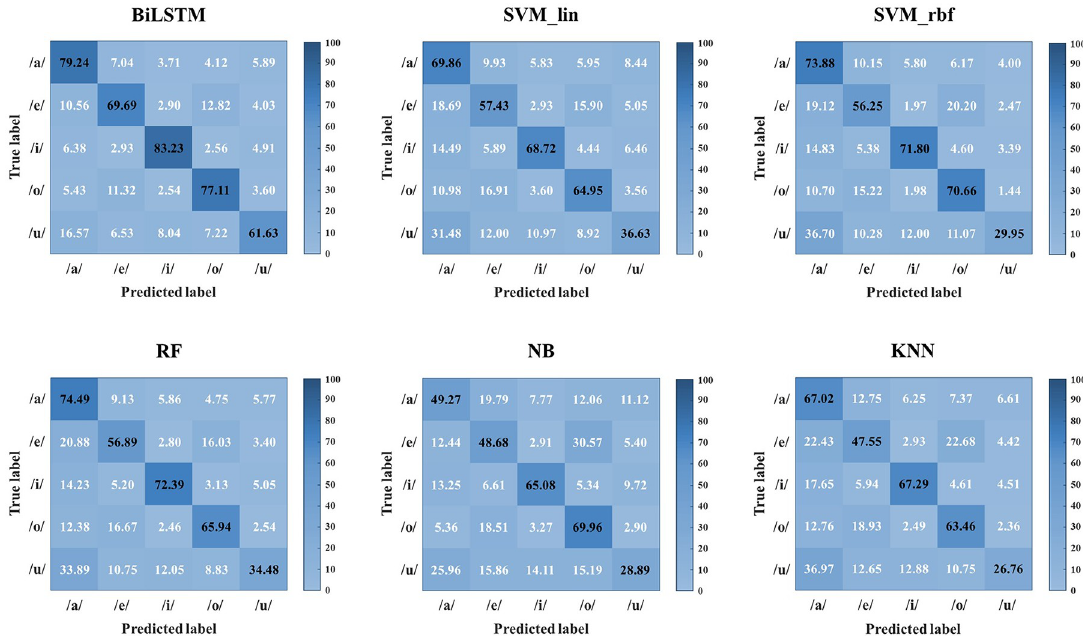
Fig 7. Confusion matrix for the BiLSTM network and other conventional machine learning classifiers. BiLSTM, bidirectional long short-term memory; SVM_lin, support vector machine with linear kernel; SVM_rbf, support vector machine with radial basis function kernel; RF, random forests; NB, na ï ve Bayes; KNN, k-nearest neighbors.